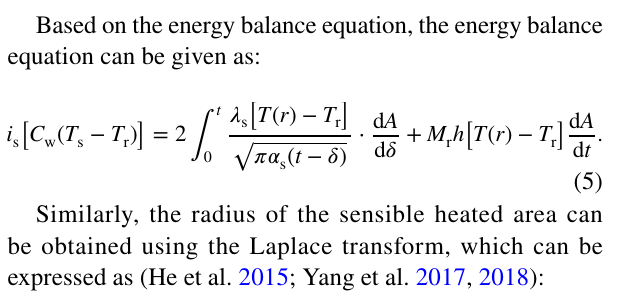
Fig. 2 The distribution of Newtonian and non-Newtonian fluid in the reservoir (Yang et al. 2017,